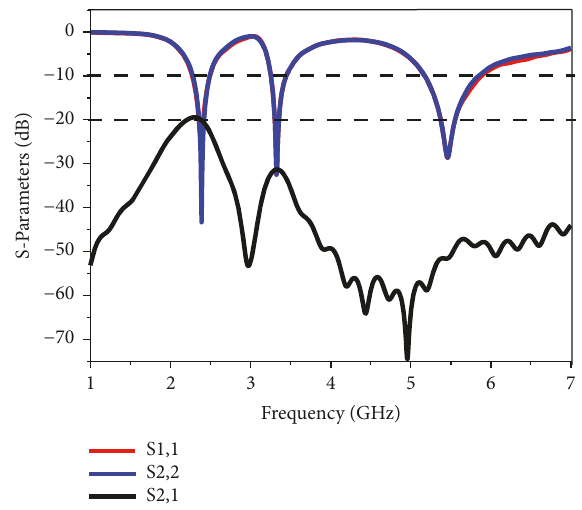
Figure 10: Simulated S parameters for the proposed MIMO antenna array of case